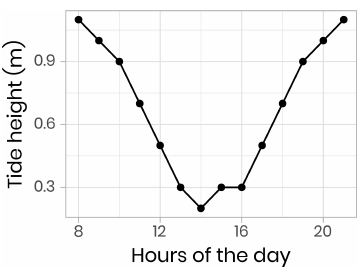
Figure A1. Surface tidal height vs. time at Qikiqtarjuaq measured on 9 June